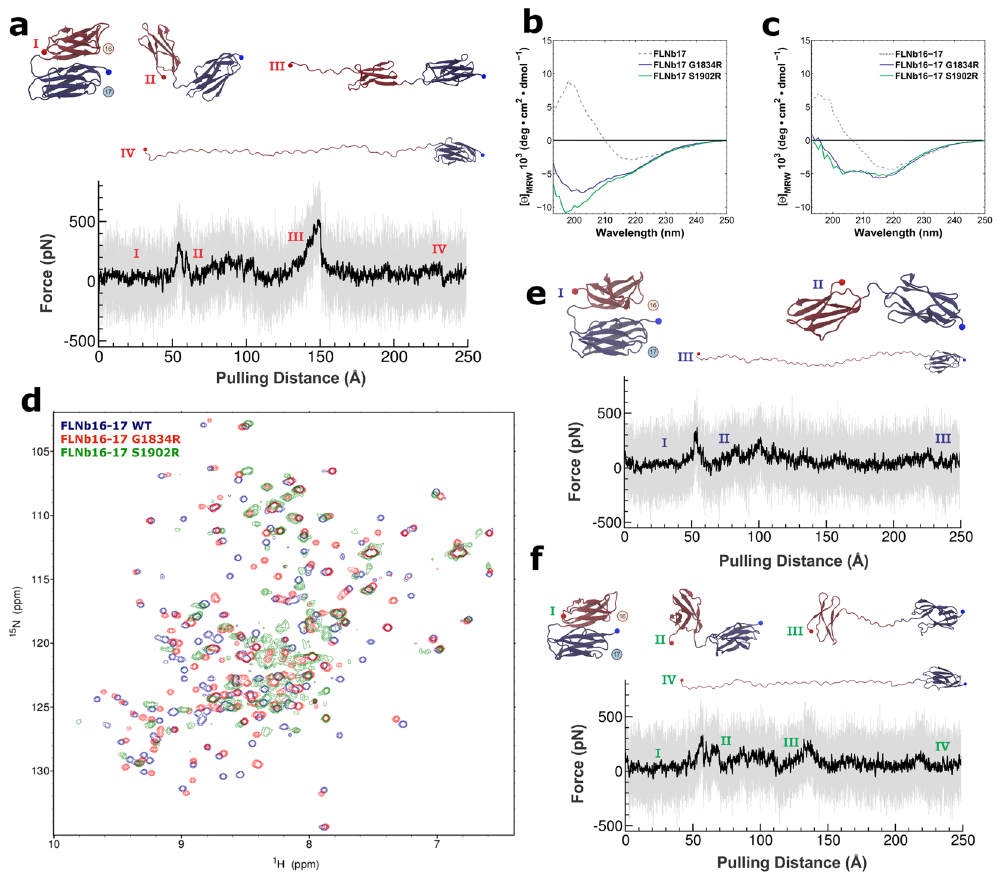
Figure 4. Effects of G1834R and S1902R mutations on FLNb16-17 structure and force response. ( a ) Unfolding trace of FLNb16-17 WT obtained from SMD a pulling speed of 2.5 Å ns − 1 shows that the interaction between domains 16 and 17 is lost first, followed by domain 16 unfolding. The full trajectory is shown gray. The black line represents a moving average with a box size of 500 steps. The snapshots of different time steps are labelled I-IV. ( b , c ) The CD-spectroscopy analyses of the WT and mutated FLNb17 ( b ) and FLNb16-17 ( c ) shows that both G1834R and S1902R destroy the β -sheet folding of FLNb17 and the neighboring domain 16 do not stabilize the β -sheet folding of mutated FLNb17 ( c ). ( d ) 1 H 15 N HSQC spectra of FLNb16-17 WT, G1834R and S1902R show that S1902R has high proportion of unfolded regions, whereas G1834R is mainly structurally ordered having only some disordered regions. ( e , f ) Unfolding traces of FLNb16-17 G1834R ( e ) and S1902R ( f ) obtained from SMD a pulling speed of 2.5 Å ns − 1 . Similarly as with FLNb16-17 WT ( a) , the interaction between domains 16 and 17 is lost before domain 16 unfolding. However, with both mutants, forces needed to unfold domain 16 are considerable lower than seen with WT. The snapshots of different time steps are labelled